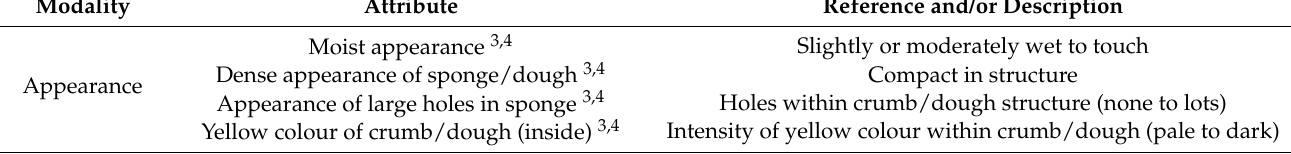
Table 3. Summary of quantitative descriptive analysis (QDA) attributes with reference and/or description for all experiments (WPBs with lactose 1 , WPBs with fat 2 , cupcakes 3 , scones 4 and scones with and without cream topping 5 ).